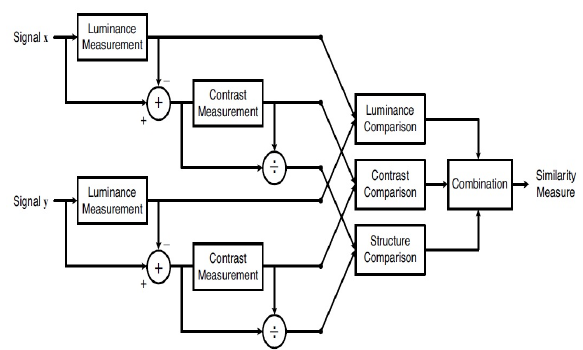
Figure 9. Diagram of the structural similarity (SSIM) measurement